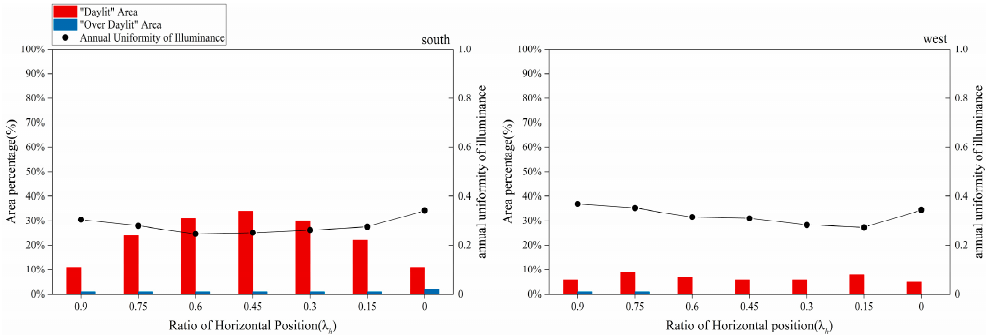
Figure 18. Shading and daylighting performance for the tested cases in Group 4.